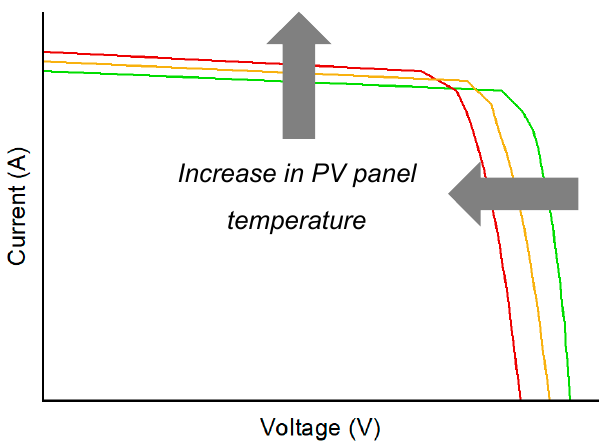
Figure 2. The impact of temperature on the operating characteristic of PV panels.